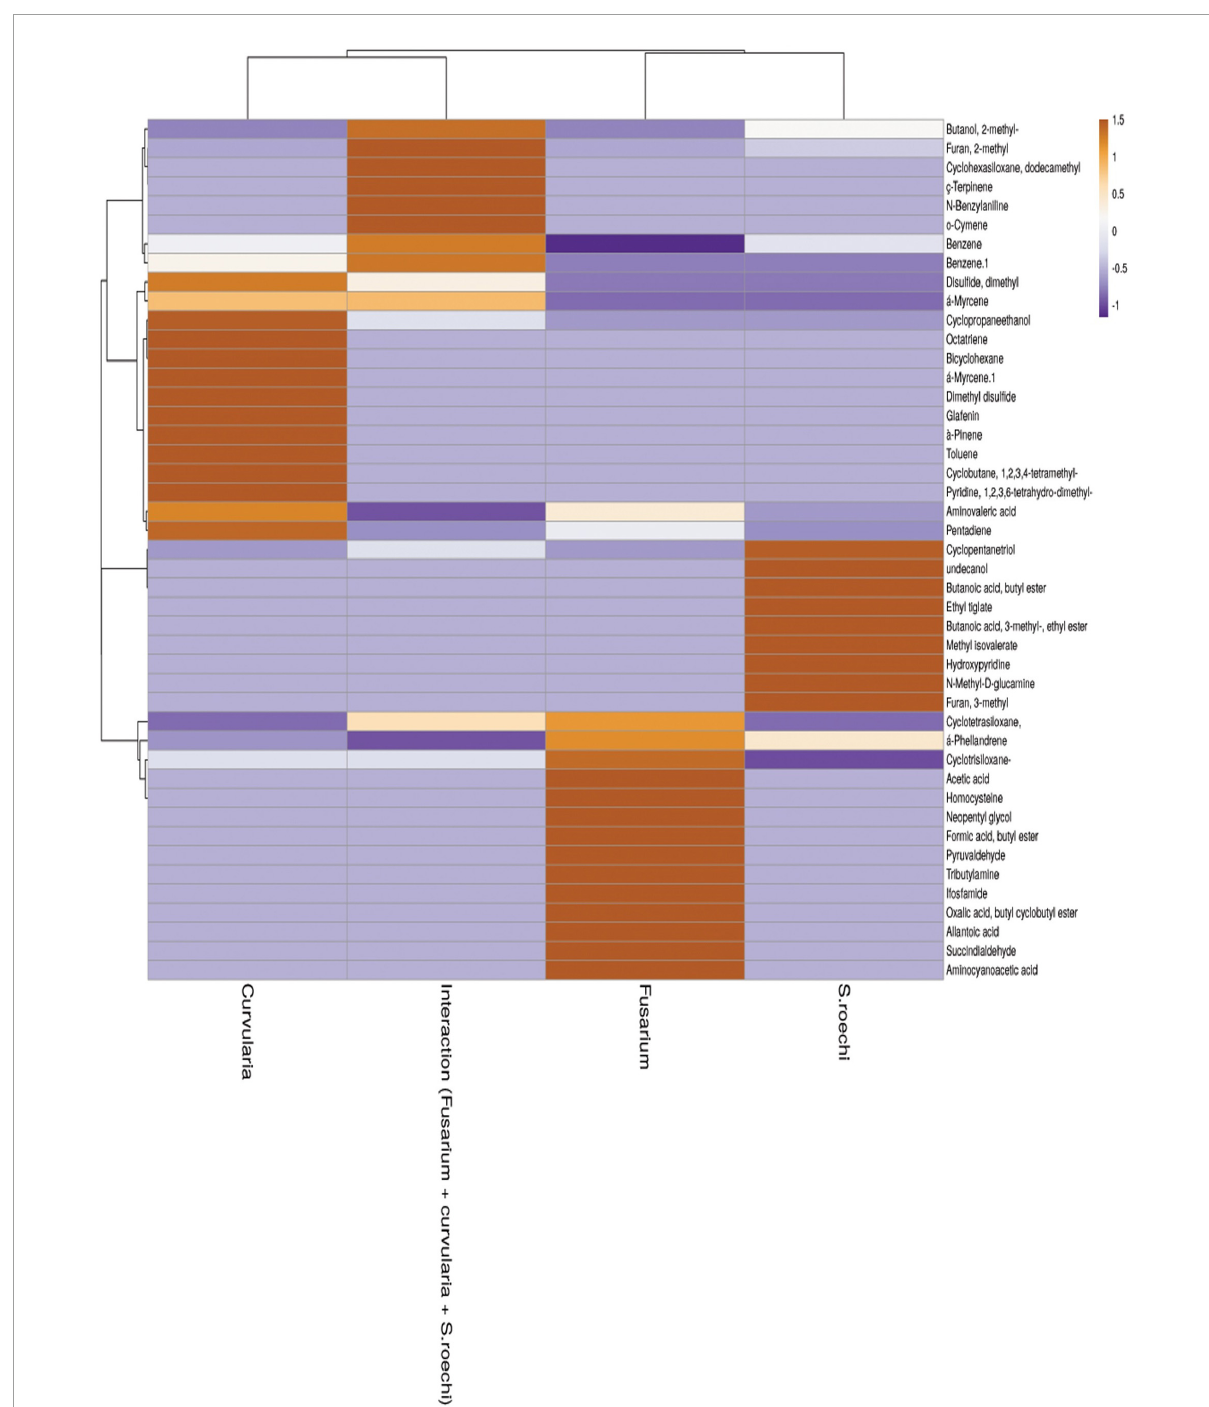
FIGURE5 Heat map obtained for upregulated and downregulated volatile compounds in axenic and